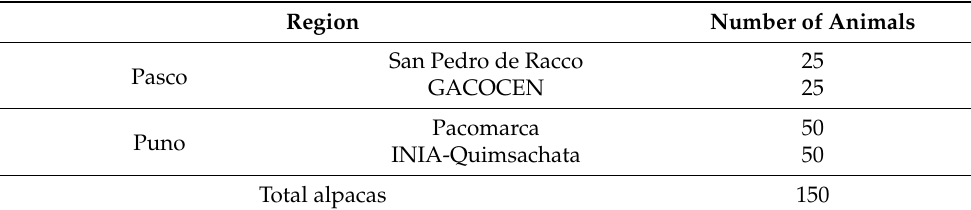
Table 1. Number of animals per region and farm within the region.